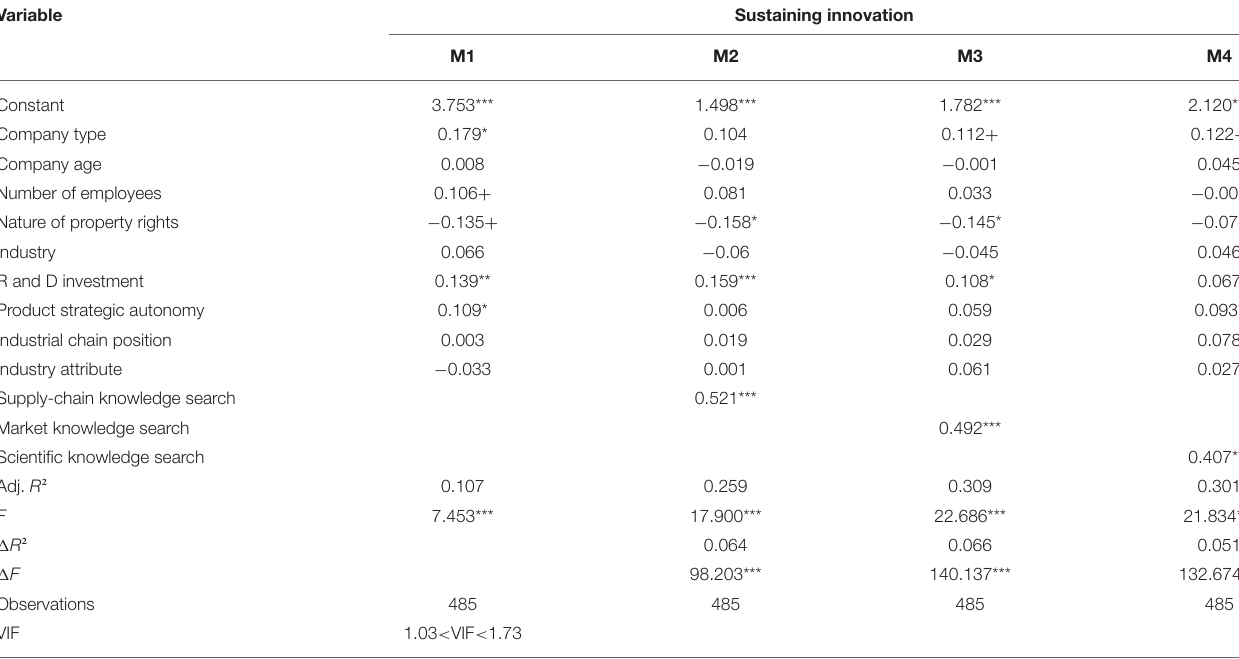
TABLE 5 | Regression results of knowledge search and sustaining innovation.